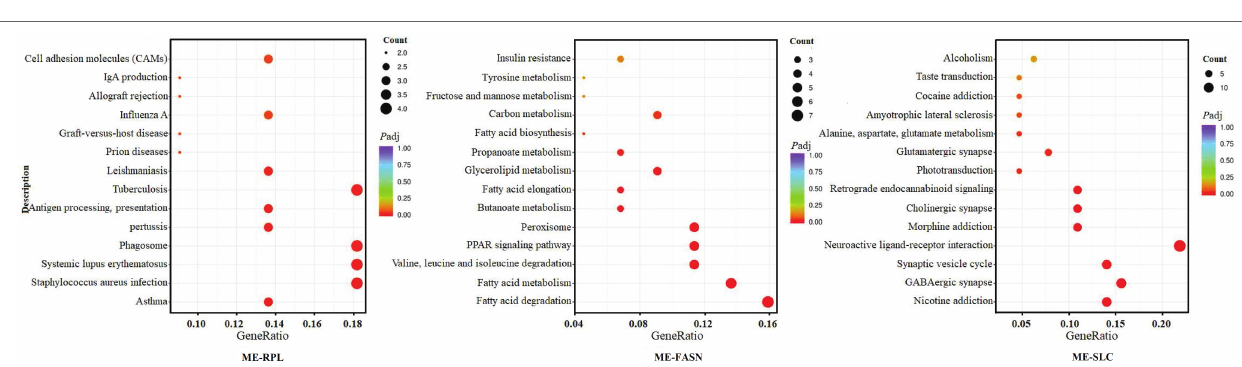
FIGURE 10 | KEGG enrichment of the significant differentially expressed mRNAs in “ME-RPL,” “ME-FASN,” and “ME-SLC.” The abscissa shows the rich factors and the ordinate represents the pathways. Size of each point indicates the number of candidate target genes in the pathway, and the color of each point corresponds to the value of p after